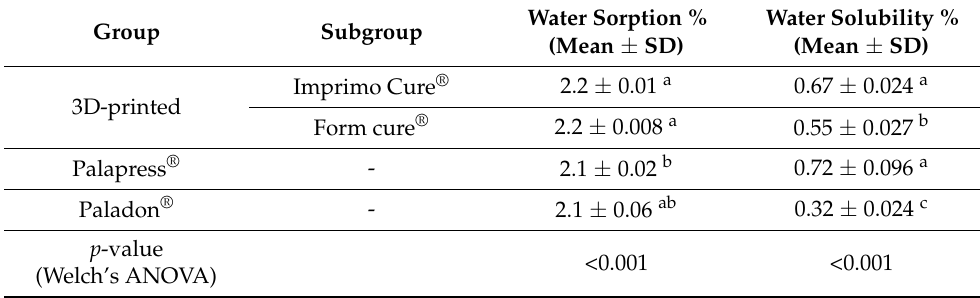
Table 3. Mean values of water sorption and water solubility % of tested groups.